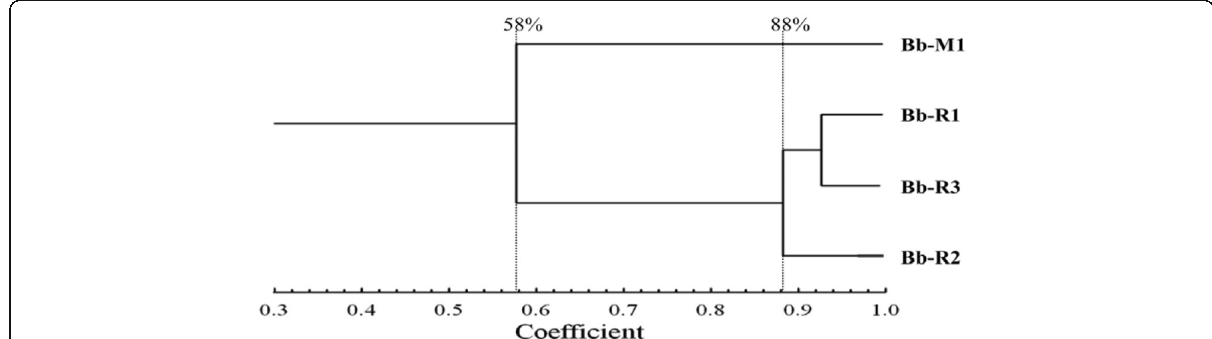
Fig. 4 RAPD-PCR data-based genetic relatedness dendrogram among different Beauveria bassiana